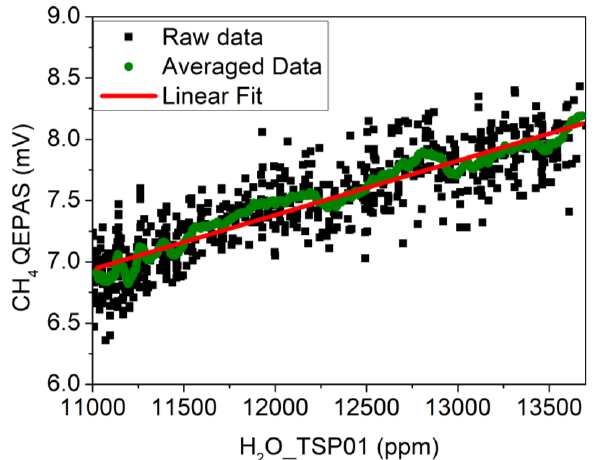
Figure 7. CH 4 QEPAS signal in standard laboratory air plotted as a function of the absolute humidity of the air measured with the TSP01 sensor (black squares). Dataset obtained with a moving average on 25 points (green circles); linear fit performed on the averaged dataset (red solid line). A moving average was implemented on the dataset with subset size of 25 (green circles). The corresponding calibration curve (red line) is the linear fit to averaged dataset, resulting in a slope of m 1 = 0.4 μV/ppm, an intercept of q 1 = 1.95 mV, and a R 2 of 0.98. This calibration curve was used to